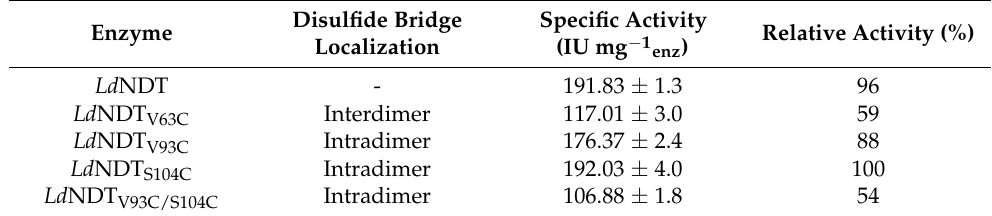
Figure 2. Overall cartoon representation of hexameric Ld NDT, including proposed mutations for the formation of inter- and intra-DSBs. The figure was prepared with PyMOL 2.5. Table 1. NDT-mediated synthesis of 2′ -deoxyadenosine (dAdo) from 2′ -deoxyuridine (dUrd) and adenine (Ade) a .